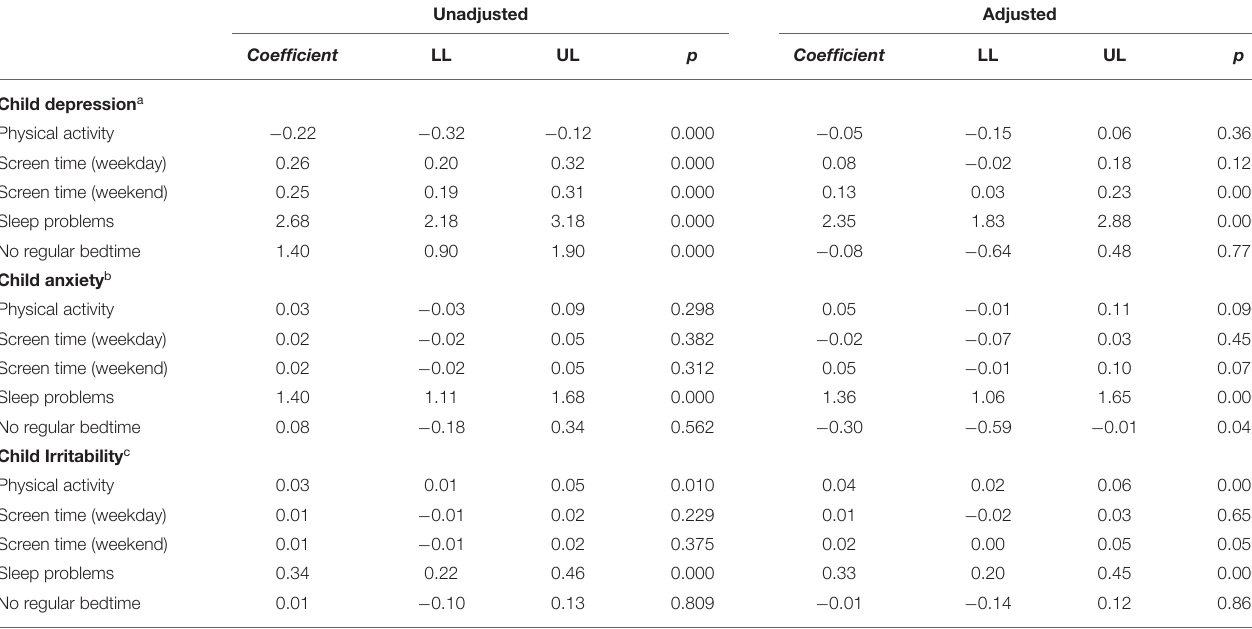
TABLE 4 | Associations between child movement behaviours (physical activity, screen time, sleep problems, and sleep routine) and mental health outcomes. Unadjusted Adjusted Coefficient LL UL p Coefficient LL UL